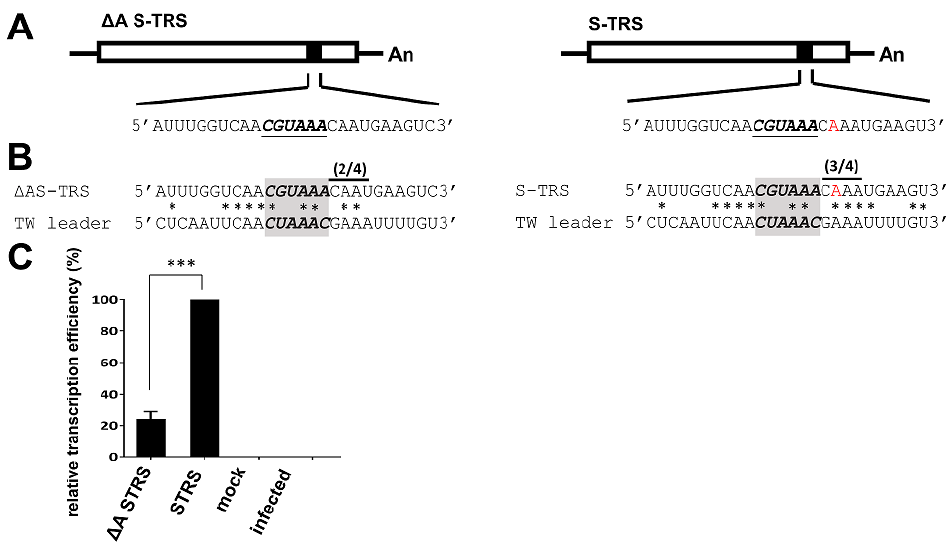
Figure 6. Effect of sequence identity between TRS-L and TRS-B on the efficiency of sgmRNA synthesis. ( A ) Genome structure of the TW DI RNA with an insertion of the TRS for S gene. In constructing ∆ A S-TRS, an A residue in the 3 (cid:48) TRS was deleted (left panel); however, in constructing S-TRS, no deletion at the same position was created (right panel). ( B ) Based on sequence alignment, deletion of the A residue from the 3 (cid:48) TRS led to 2-nt identity of the 3 (cid:48) TRS between TRS-L and TRS-B (left panel). In contrast, without the A residue deletion, three nts of the 3 (cid:48) TRS are identical between TRS-L and TRS-B in constructing S-TRS (right panel). ( C ) Relative efficiency of sgmRNA synthesis between ∆ A S-TRS and S-TRS, as quantitated by RT-qPCR. The values in C represent the means ± SD of three individual experiments. *** p < 0.001.